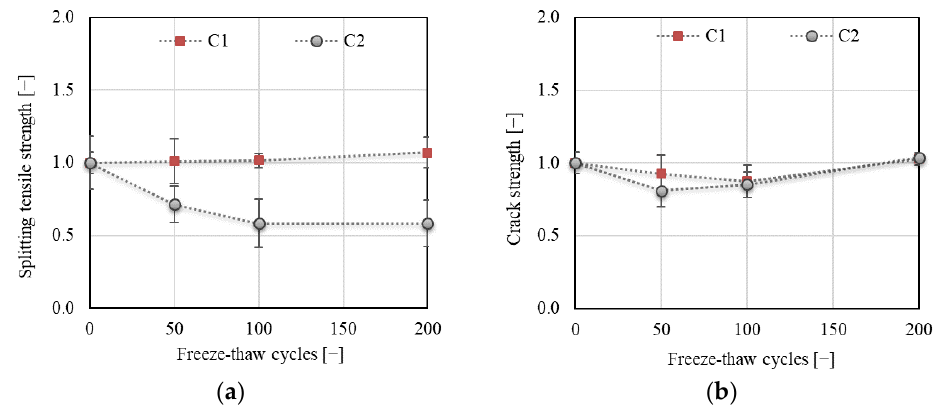
Figure 10. ( a ) Splitting tensile strength; ( b ) crack